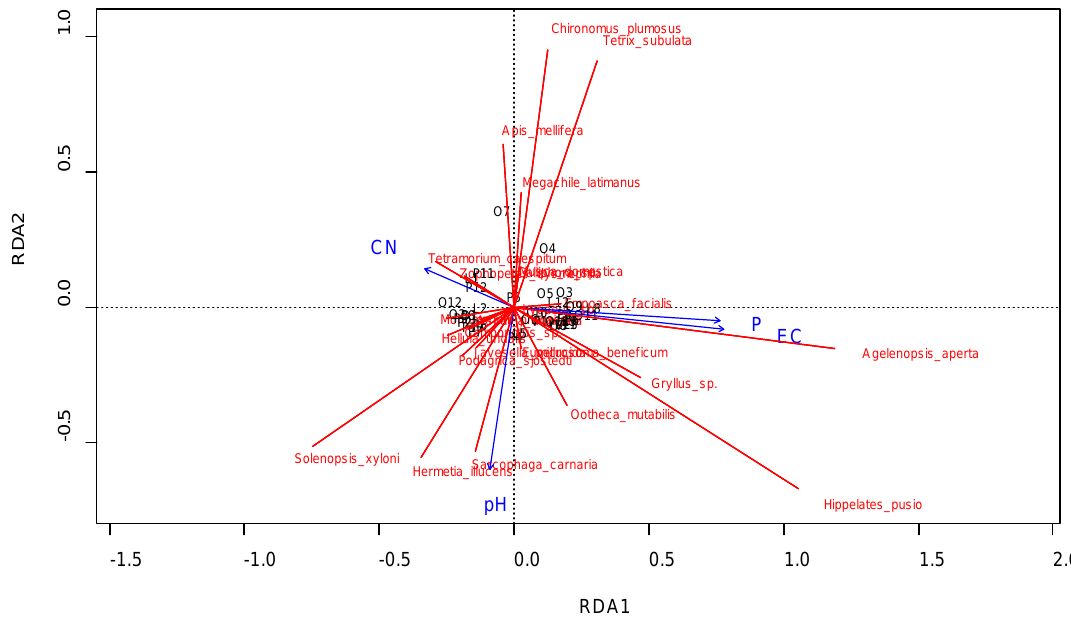
Figure 5. RDA (redundancy analysis) triplot (scaling 1) showing the relationship between soil carbon-to-nitrogen ratio (C / N), soil electric conductivity (EC), soil phosphorous content (P), and soil pH to the shortlisted 24 arthropod species sampled for 72 h in UPA systems of Tamale, Northern Region, Ghana, in August 2016.